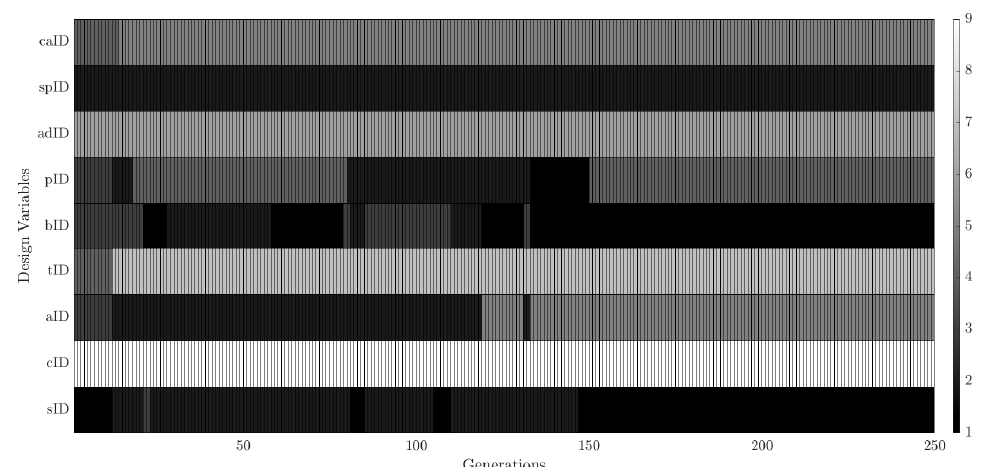
Figure 13. Variation of the design variables in the subsystem specifier over generations where the color denotes the component selected from the inventory.